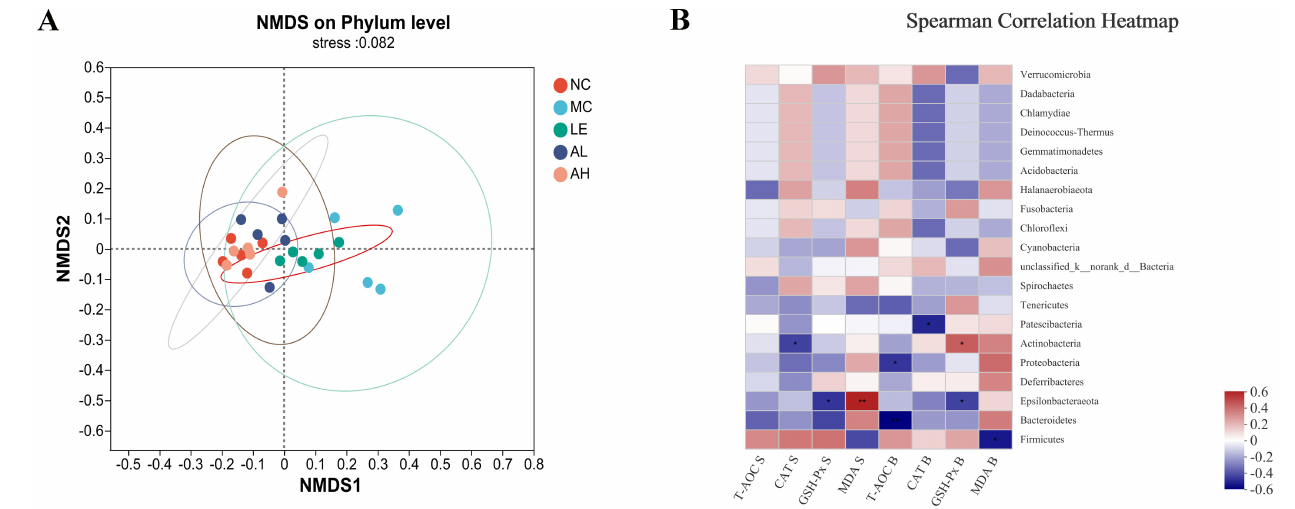
Figure 7. Beta diversity analysis of gut microbiota and correlation analysis between the relative abundance of gut microbiota and biomarkers. ( A ) Non-metric Multidimensional Scaling (NMDS) analysis on phylum level based on Bray-Curtis metrics. ( B ) Spearman correlation heatmap anal- ysis between the relative abundance of gut microbiota and the oxidative stress biomarkers. LE, 300 mg/kg.bw/d Lentinan; AL, 300 mg/kg.bw/d AAPS; AH, 600 mg/kg.bw/d AAPS. * p < 0.05 vs. NC group. ** p < 0.01 vs. NC